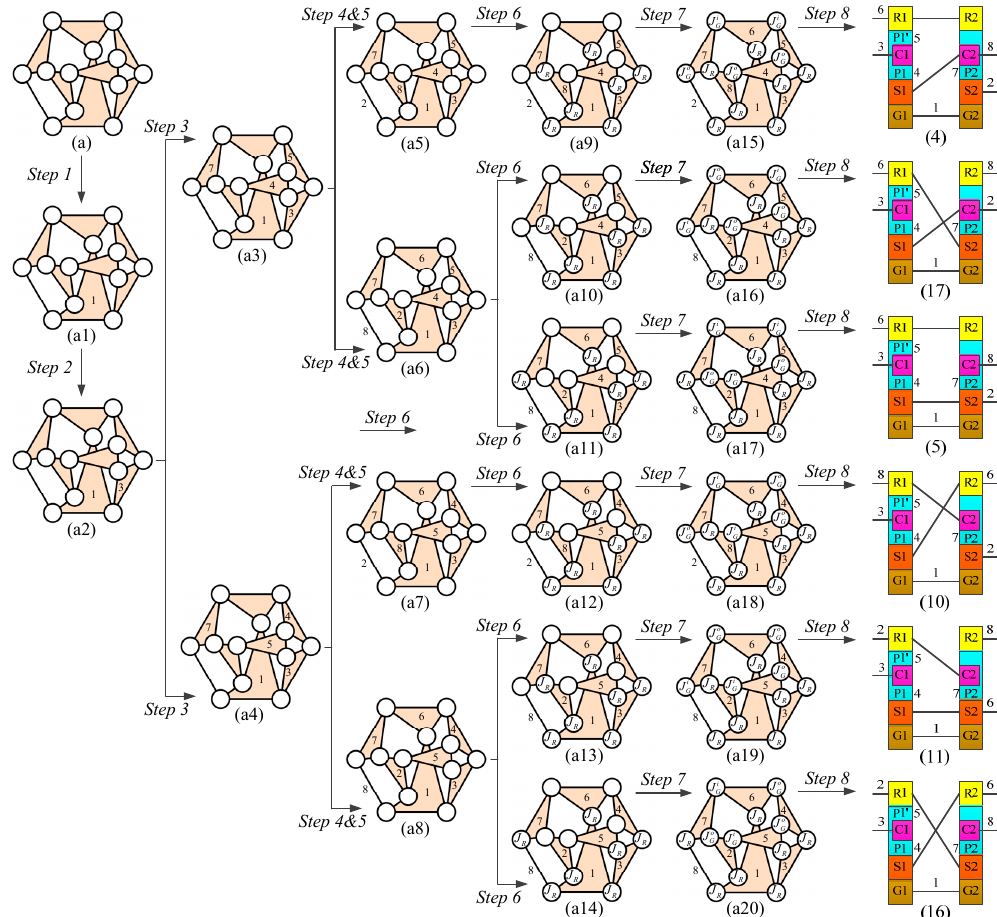
Figure 4. Process of specialization.